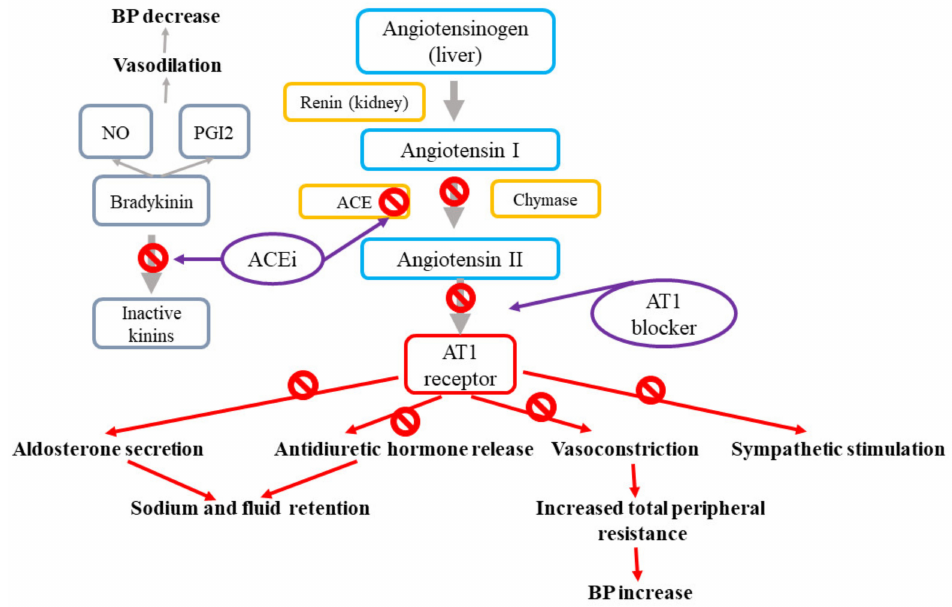
Figure 2. Mechanisms of action of angiotensin-II receptor blockers and angiotensin-converting enzyme